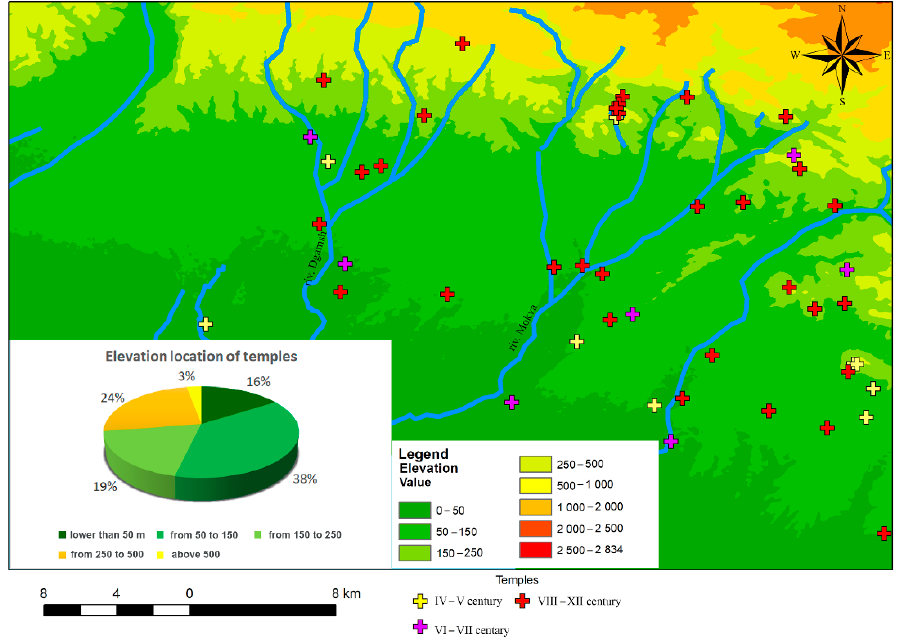
Figure 6. Temples in the areas of the Dgamsh and Mokva rivers.